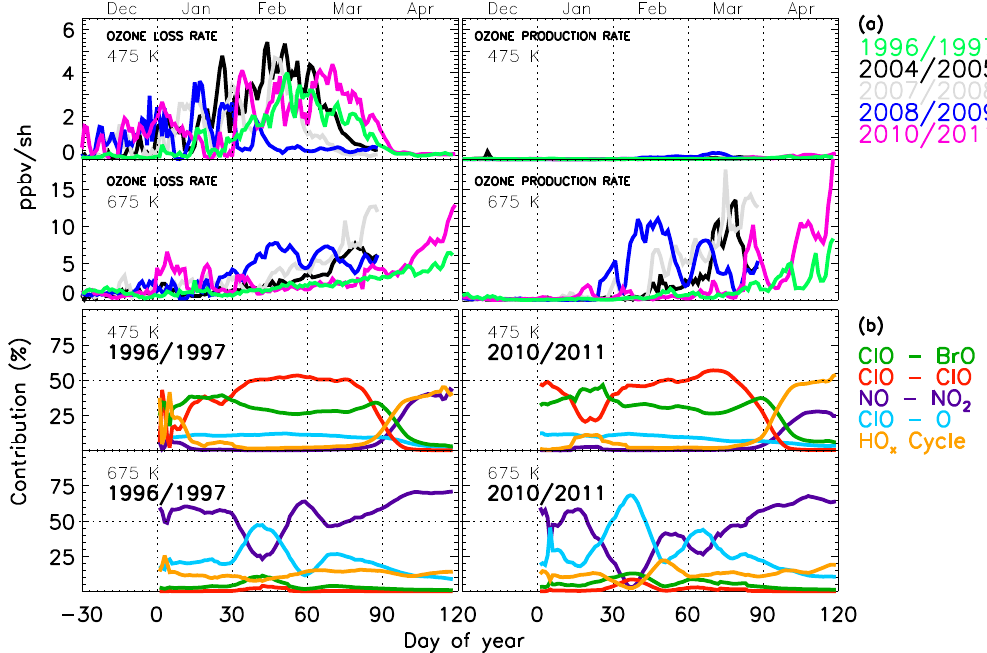
Fig. 6. (a) Vortex-averaged instantaneous ozone loss rates (left panel) and production rates (right panel) simulated by Mimosa-Chim at 475 K and 675 K for the Arctic winter 1996/1997 (light green) and 2010/2011 (magenta) compared to those of 2004/2005 (black), 2007/2008 (grey), and 2008/2009 (blue). (b) Temporal evolution of the vortex-averaged contribution of the ClO-BrO (dark green), ClO-ClO (red), NO-NO 2 (violet), ClO-O (light blue), and HO x (yellow) chemical cycles during the Arctic winter 1996/1997 (left panel) and 2010/2011 (right panel) at 475 K and 675 K. The dotted horizontal lines represent 50 % of contribution and the vertical dotted lines mark the approximate boundaries of each month.